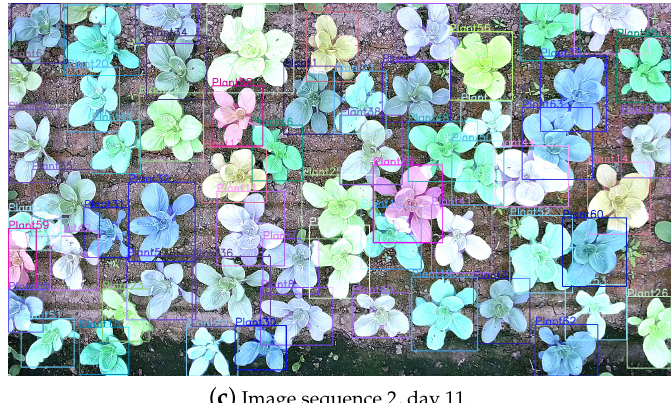
Figure 6. Visualized results of leafy greens instance tracking. Each leafy green has a unique ID that remains the same during tracking and is noted in the upper left corner of the bounding box.